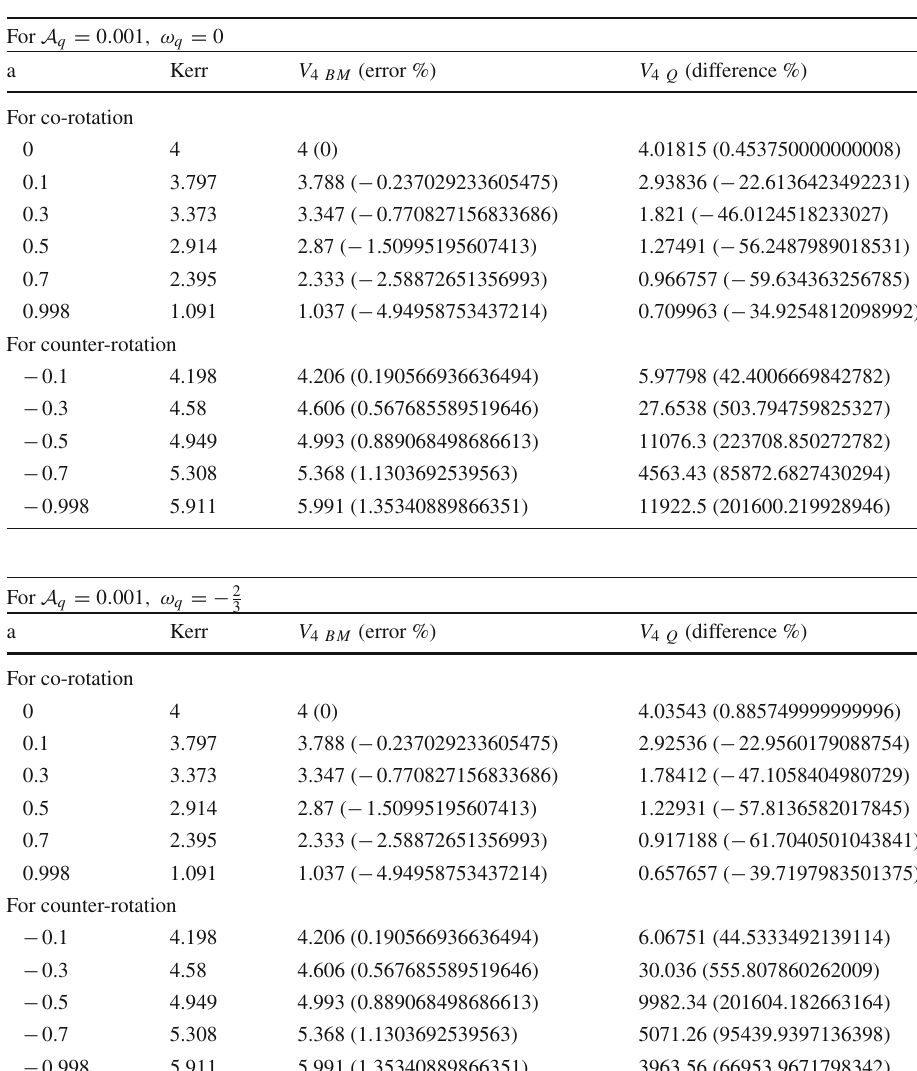
PNPs for very low DE effect in pressure-less dust